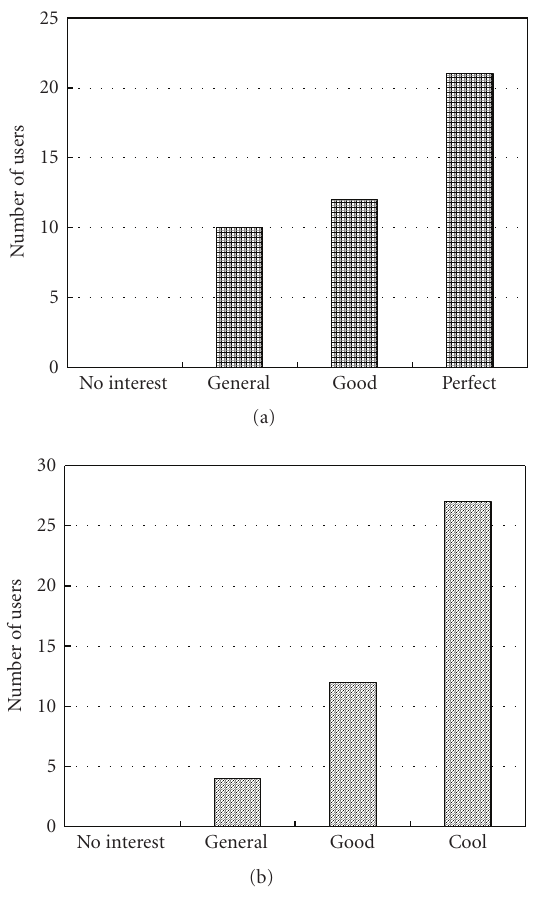
Figure 2: User study results on (a) view switching and (b) frozen